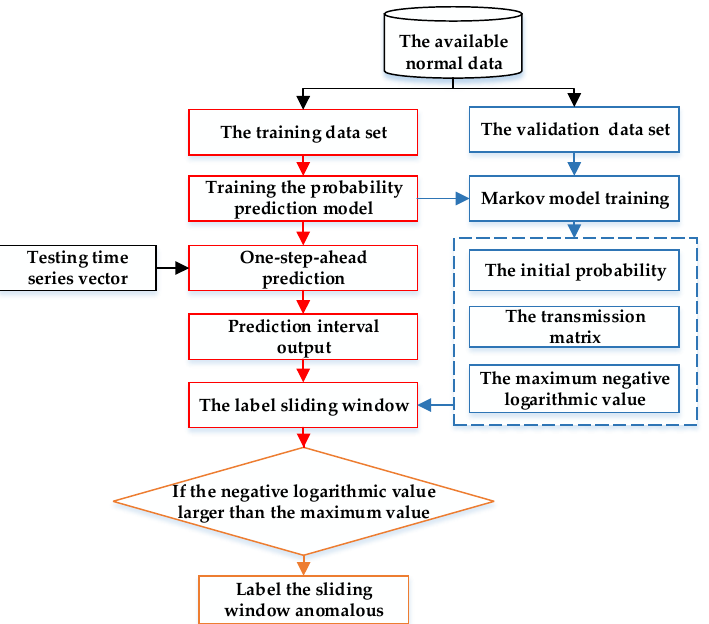
Figure 4. The proposed anomaly detection with the fusion of probability prediction and Markov chain model.